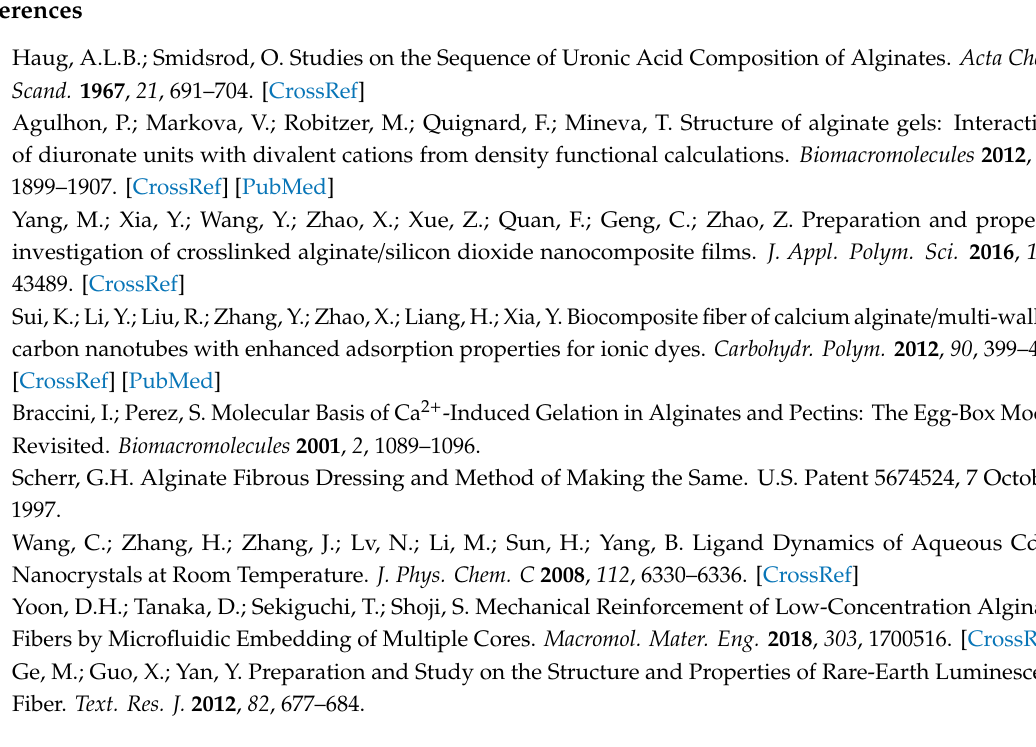
Figure S1: Optical photos of both the MEA-CdTe NCs dispersion (the left bottle) and the CdTe / SA blend (the right bottle) under (a) daylight and (b) UV-light. Figure S2: (a) Optical photos of the ME-CdTe NCs dispersion and the ME-CdTe / SA blend (in which the ME-CdTe concentration is 0.25 mM) under UV-light. (b) PL spectra of the ME-CdTe NCs dispersion and the ME-CdTe / SA blend after stored in the dark for 30 days. Figure S3: PL spectra of TGA-CdTe NCs dispersion and TGA-CdTe / SA blend with the same NCs concentration of 5.0 mM after been stored for 30 days. Figure S4: Rheological properties of SDs and the 4wt% SA solution at 50 ◦ C: (a) shearing rate ( γ ) dependence of viscosity ( η ); (b) angular frequency dependence ( ω ) of storage modulus (G’) and loss modulus (G”). Inset: the magnification of the intersection of G’ and